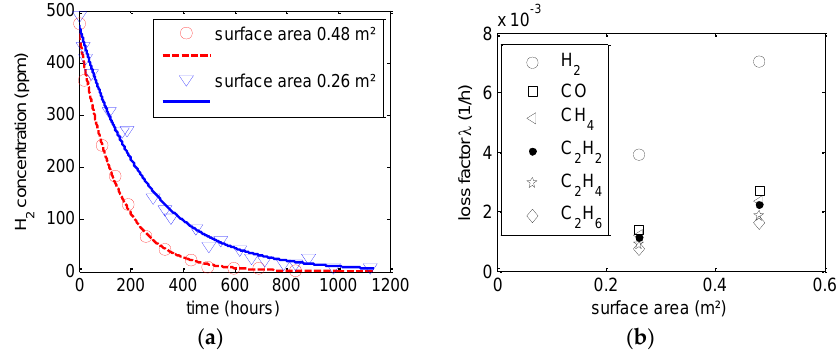
Figure 16. ( a ) Concentration trend of hydrogen for different boundary surface areas; and ( b ) gas loss factor over surface area for different fault gases.